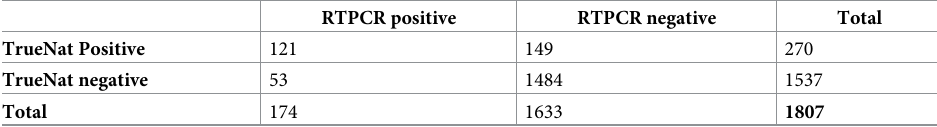
Table 1. Comparison of the positivity rates of TrueNat with RTPCR results.